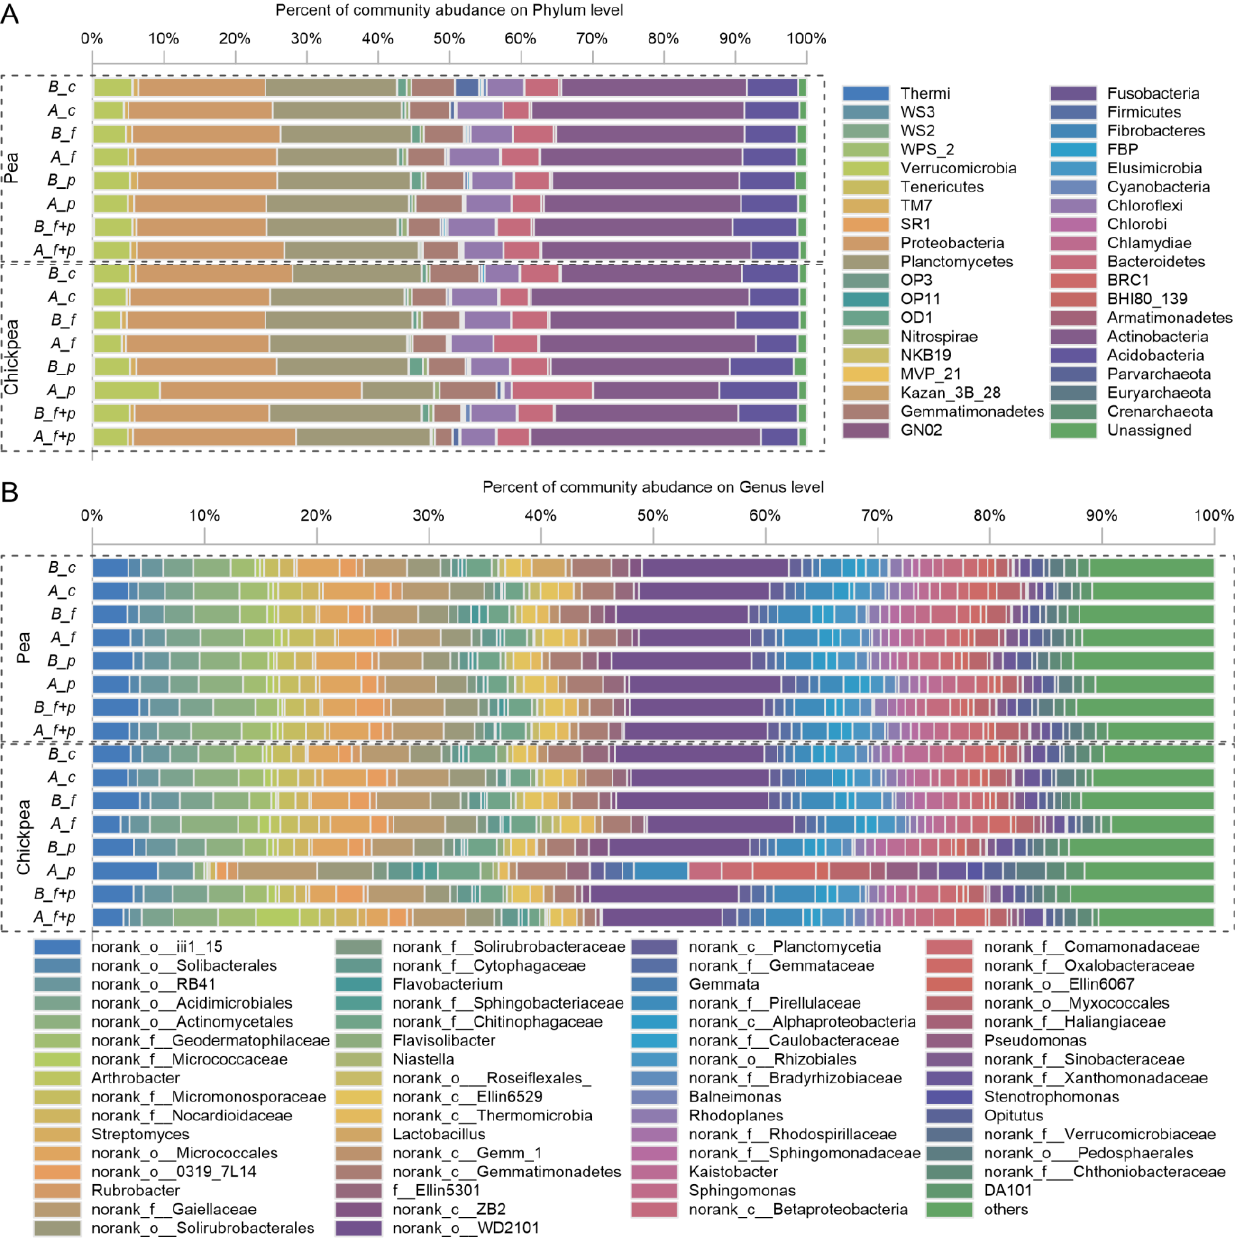
Figure 1. Relative abundance of soil bacterial communities at the phylum ( A ) and genus ( B ) levels in soils under pea and chickpea before ( B_ ) and after ( A_ ) plant protection application under different treatment conditions: control ( c ), fertilization ( f ), pesticide application ( p ), and combined treatment (f +p ). The taxa were classified as “others” when the relative abundance was less than 1%.